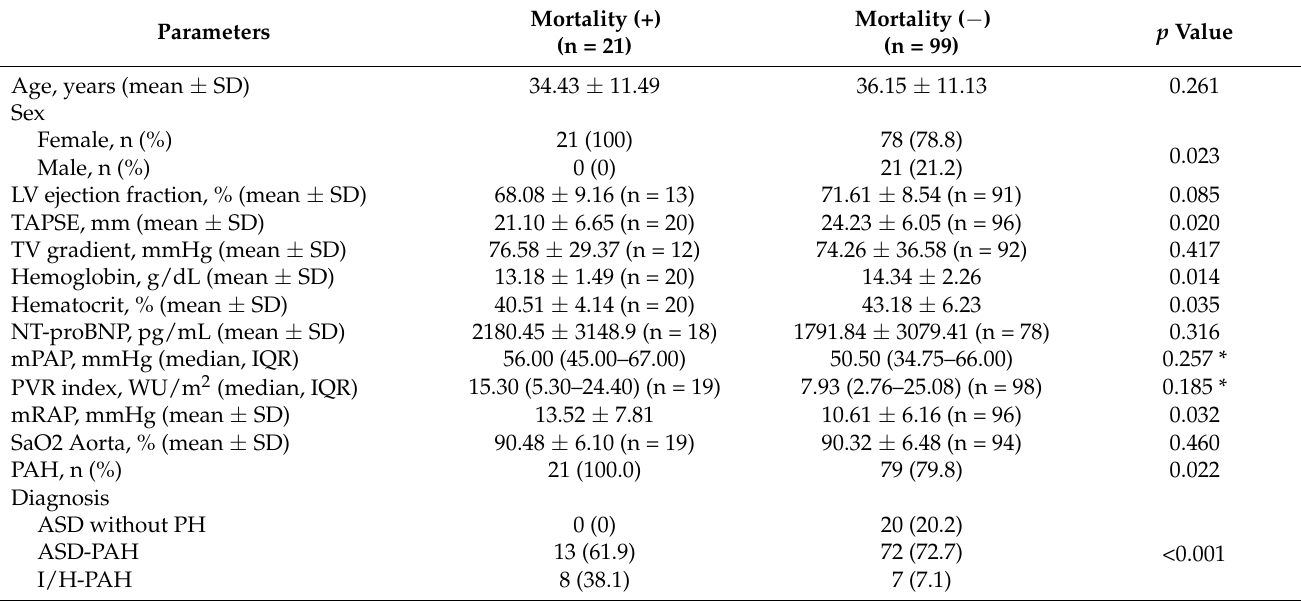
Table 3. Comparison of characteristics between all subjects who died (mortality (+)) and those who survived (mortality ( −